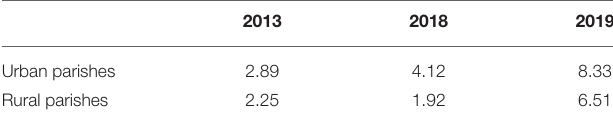
TABLE 1 | Index of abundance of free roaming dogs (number of dogs/km) in urban and rural parishes in Quito (indices calculated from raw data of the 2013, 2018, and 2019